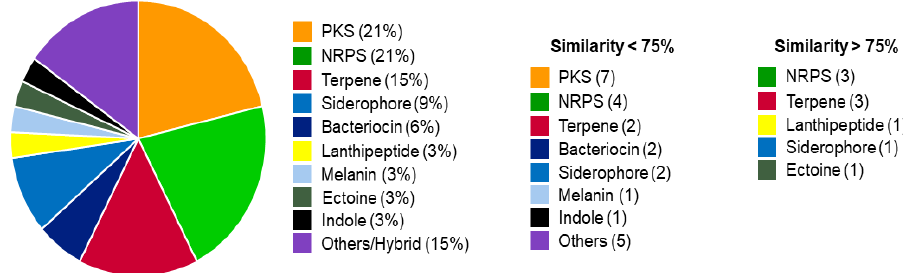
Figure 2. Biosynthetic gene clusters predicted from this strain using antiSMASH. Out of the 33 clusters identified, 24 clusters possess genes with less than 75% similarity to that of known compounds.